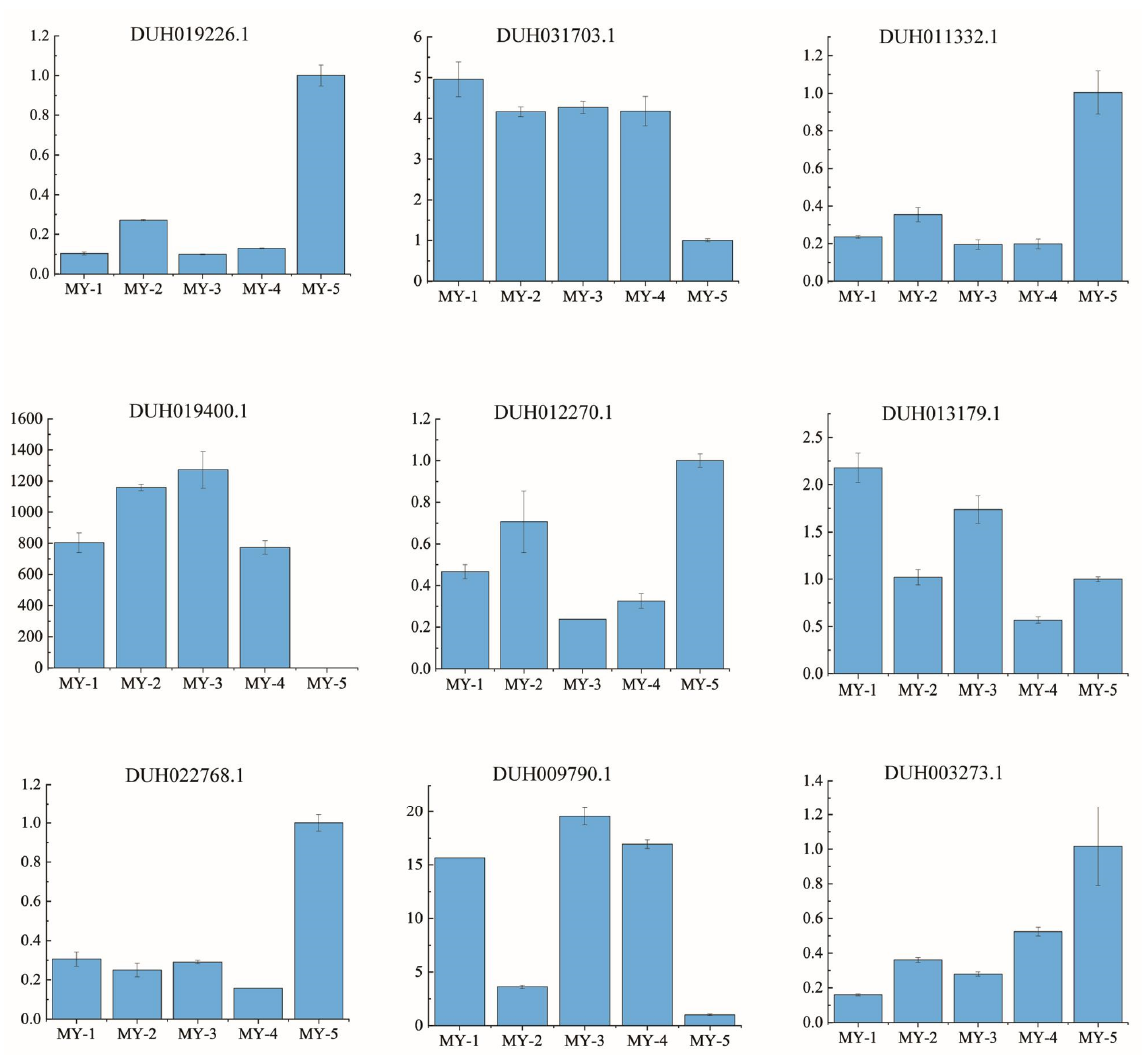
Figure 11. qRT-PCR verification of the transcriptome result. Expression levels of nine genes in different tissues: MY-1, spotted petals; MY-2, unspotted petals; MY-3, spotted throat; MY-4, unspotted throat; MY-5, branchlet cortex. The 18s gene was applied as a reference gene. Relative gene expression was calculated with MY-5 as control. Each column represents the mean ± standard error of the expression of three independent experiments with three replications.